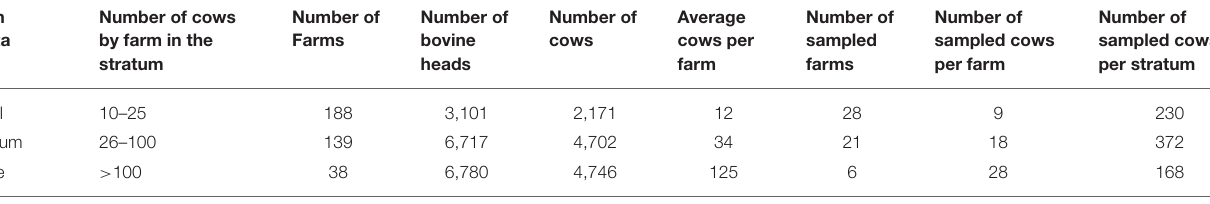
TABLE 1 | Cross sectional survey, sampling procedure (assumes 95% CI and 10% accepted error) based on the population of the study area.